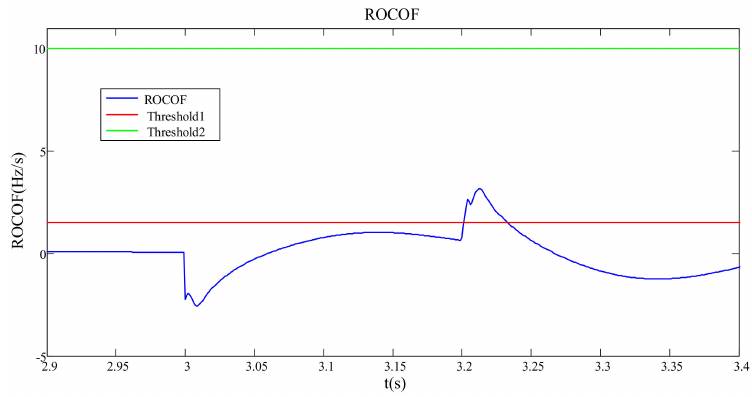
Figure 12. The output of ROCOF relay in short circuit